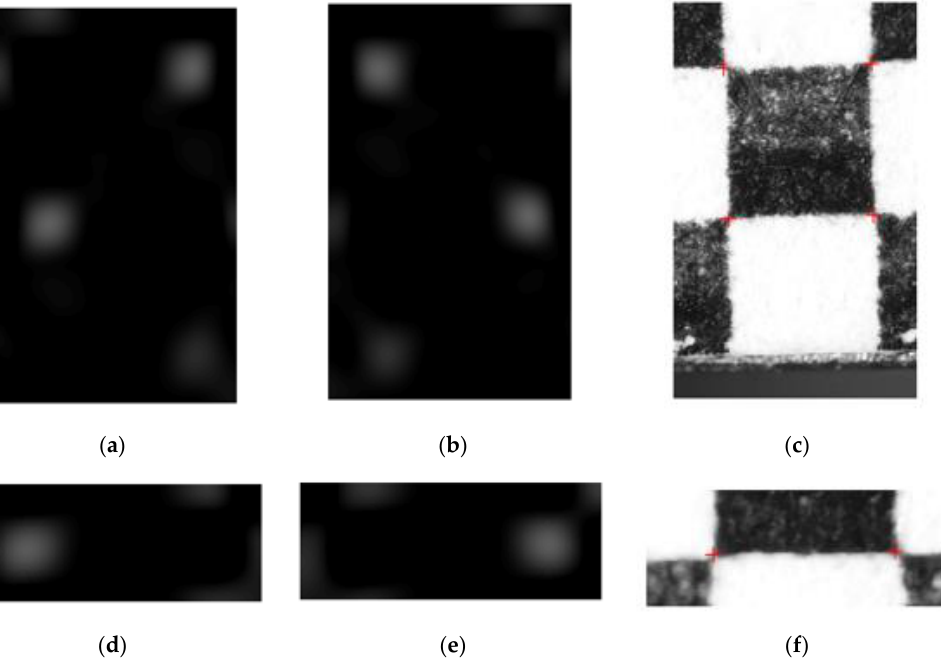
Figure 6. The result of filtering the checkerboard image on the moving ( a , b ) and still ( d , e ) handle and images of the handles themselves ( c , f ) with the corner detection points marked in red. Pictures ( b , e ) show the result of filtering with a filter with a mask rotated by 90°. The coordinate sets of the points of the detected edges and corners were input infor- mation to the algorithm for the analysis of image data. The image coordinates were con- verted to metric coordinates (mm) based on information about the spatial resolution of the images and the arbitrarily assumed place of the beginning of the coordinate system (associated with the place where the sample is handled in a still holder). The shape of the edge of the test sample in subsequent images of the recorded se- quence is shown in Figure 7.